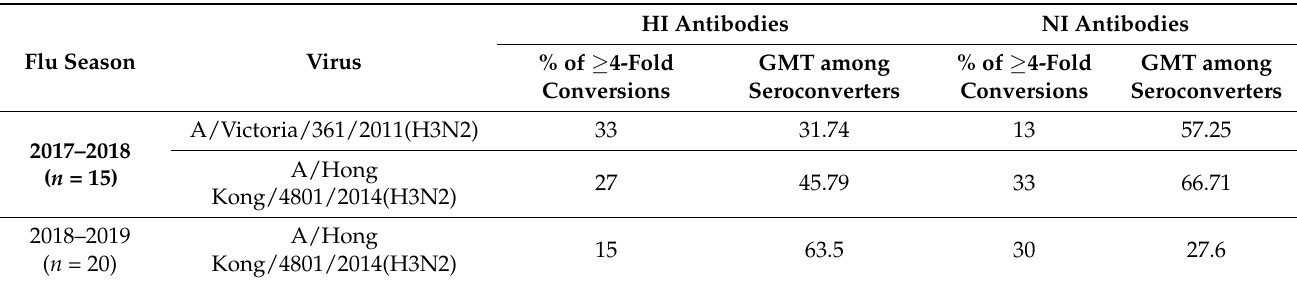
Figure 2. Antibodies to HA and NA of A/H3N2 influenza viruses in paired sera of patients with PCR confirmed influenza A infection. S1-sera obtained upon admission to the hospital, S1-sera obtained on days three to eight of hospital stay. ( A )—antibodies to HA and NA of A/Victoria/361/2011(H3N2) in the sera obtained in 2017–2018 flu season ( n = 15), * p < 0.05. ( B )—antibodies to HA and NA of A/Hong Kong/4801/2014(H3N2) in the sera obtained in 2017–2018 flu season ( n = 15), * p < 0.05; ** antibody levels at the start of hospitalization to A/Victoria/361/2011(H3N2) virus were significantly higher than to A/Hong Kong/4801/2014(H3N2) virus, p < 0.01. ( C )—antibodies to HA and NA of A/Hong Kong/4801/2014(H3N2) in the sera obtained in 2018–2019 flu season ( n = 20), * p < 0.05. Table 1. SeroconversiontoantigensofA/Victoria/361/2011(H3N2)andA/HongKong/4801/2014(H3N2) in paired sera of influenza